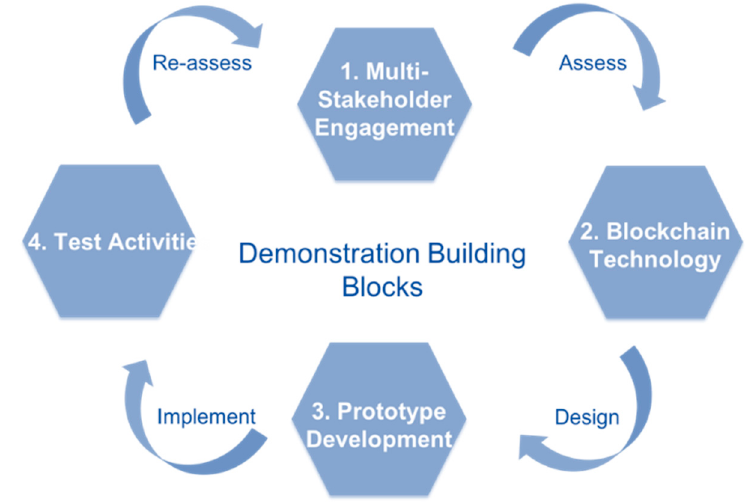
Figure 1. Demonstration Building